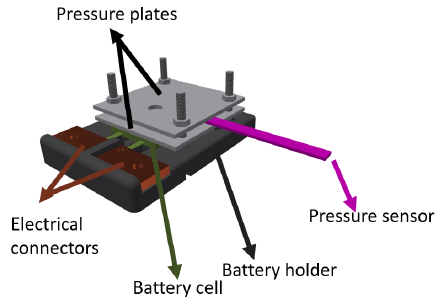
Figure 2. Pressure setup to monitor developed perpendicular counterforce due to repeated (de-)lithiation of the Si-alloy full cells